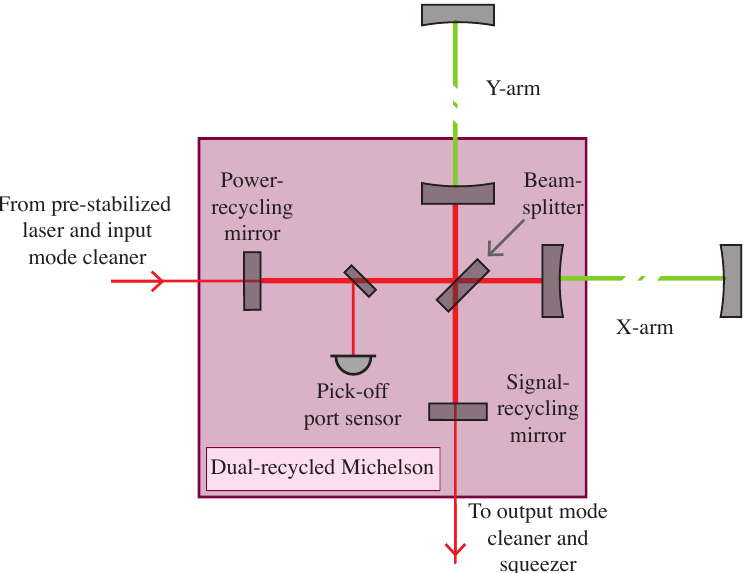
Figure 3. Interferometer layout during the second stage of lock acquisition: dual-recycled Michelson locking. With the arms locked on green, the arms are held off-resonance for infrared so the corner degrees of freedom can be locked independently of the arms. The dual-recycled Michelson is shown in the pink box. DRMI has three length degrees of freedom: the Michelson length (MICH), signal- recycling cavity length (SRCL), and power-recycling cavity length (PRCL). The photodiode at the pick-off port is used to sense all degrees of freedom: each degree of freedom is detected via different phase modulation sideband frequencies which resonate in different cavities